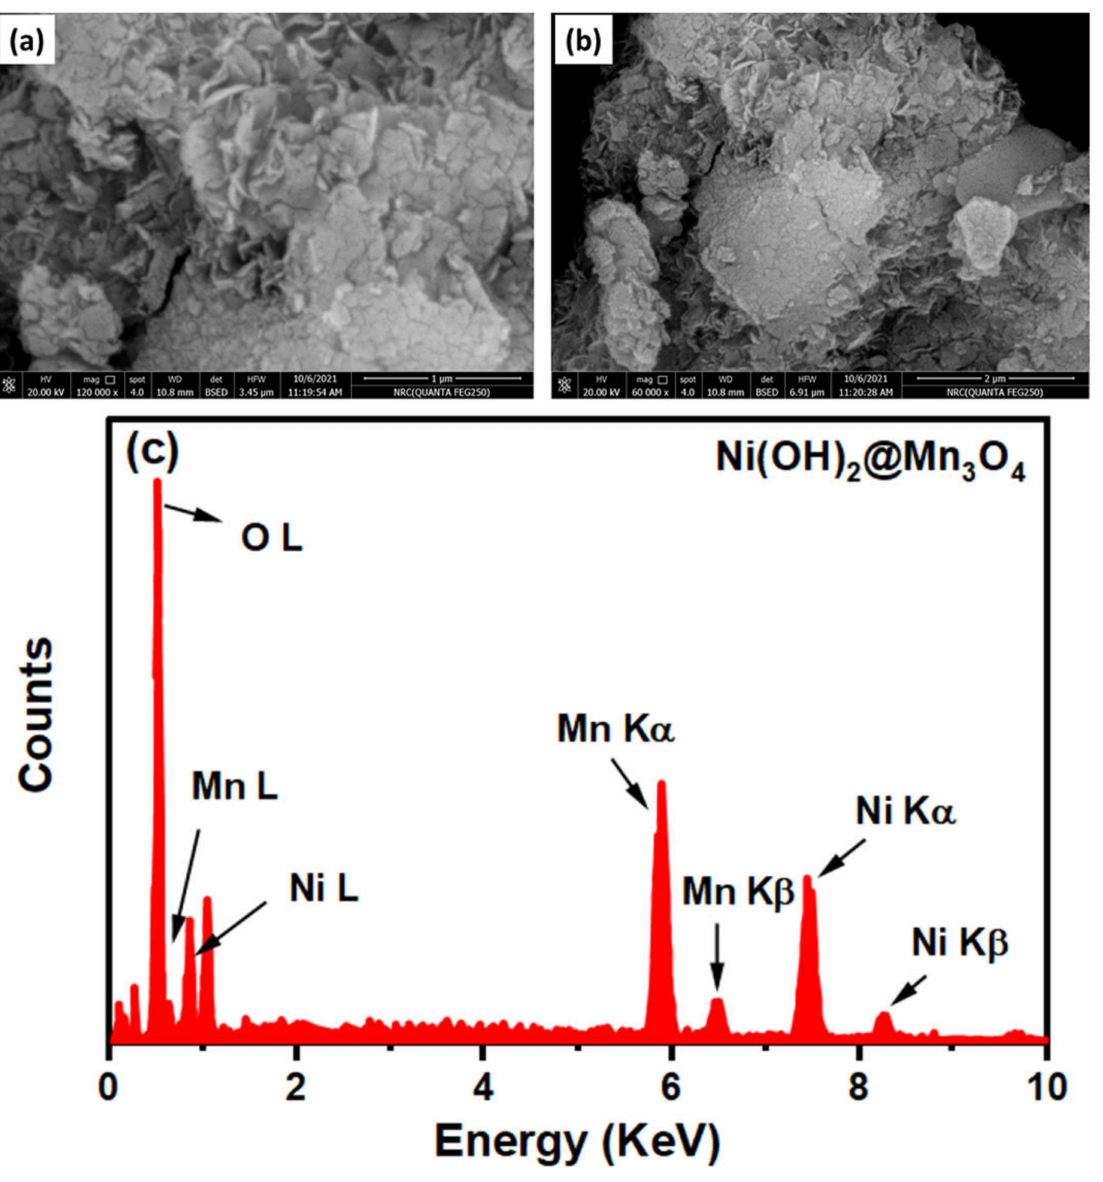
Figure 2. ( a , b ) FE-SEM images with different magnification scales ( c ) Energy Dispersive Spectroscopy (EDS) for Ni(OH) 2 @ Mn 3 O 4